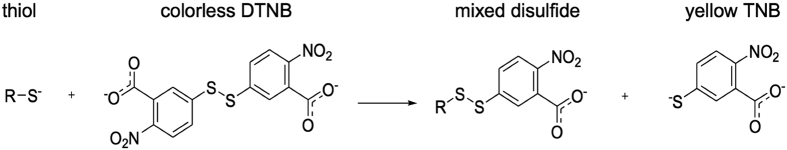
Reaction of the Ellman’s reagent (DTNB) with a thiol.